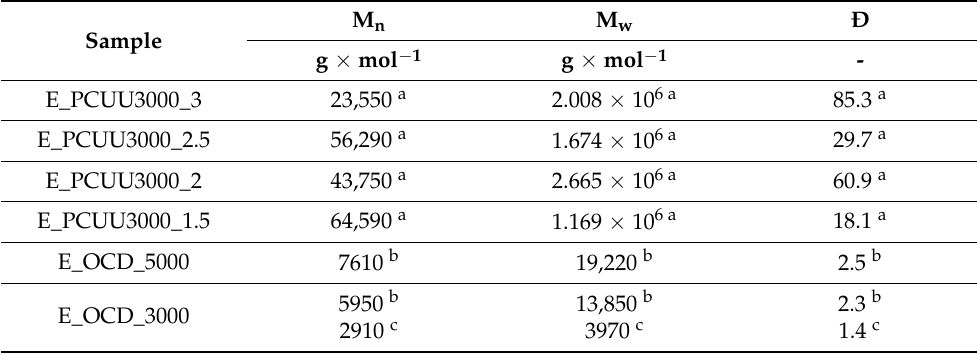
Table 1. Molar mass and dispersity